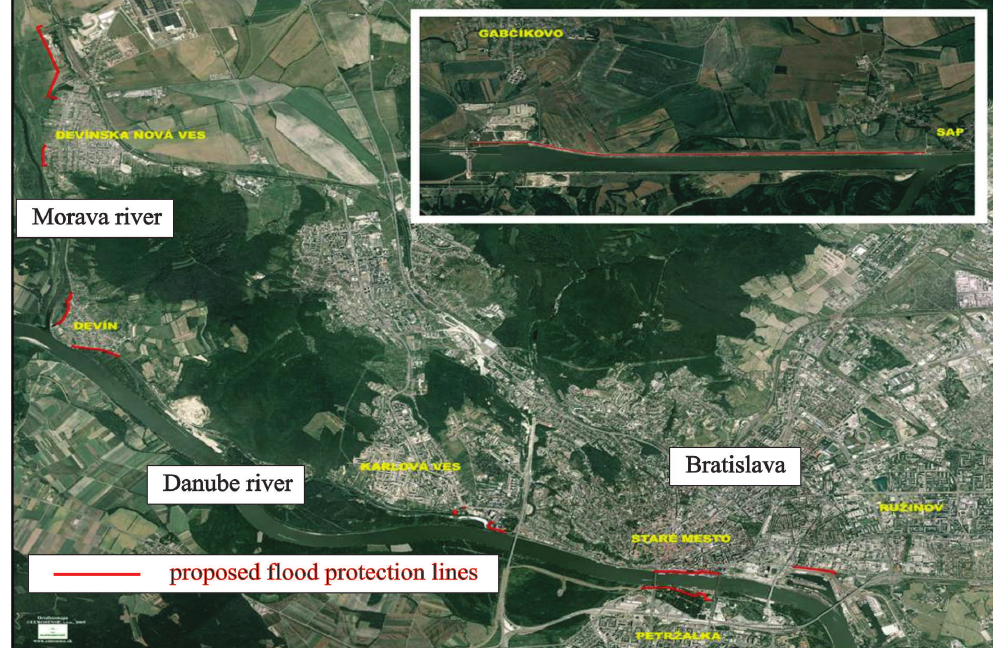
Fig. 4. Proposed flood protection lines in the city of Bratislava and its surroundings (e.g. Gabˇcikovo). The figure in the upper right corner shows an improvement to the safety of dikes on the left-hand side channel of Gabˇcikovo, which is located about 50km downstream from